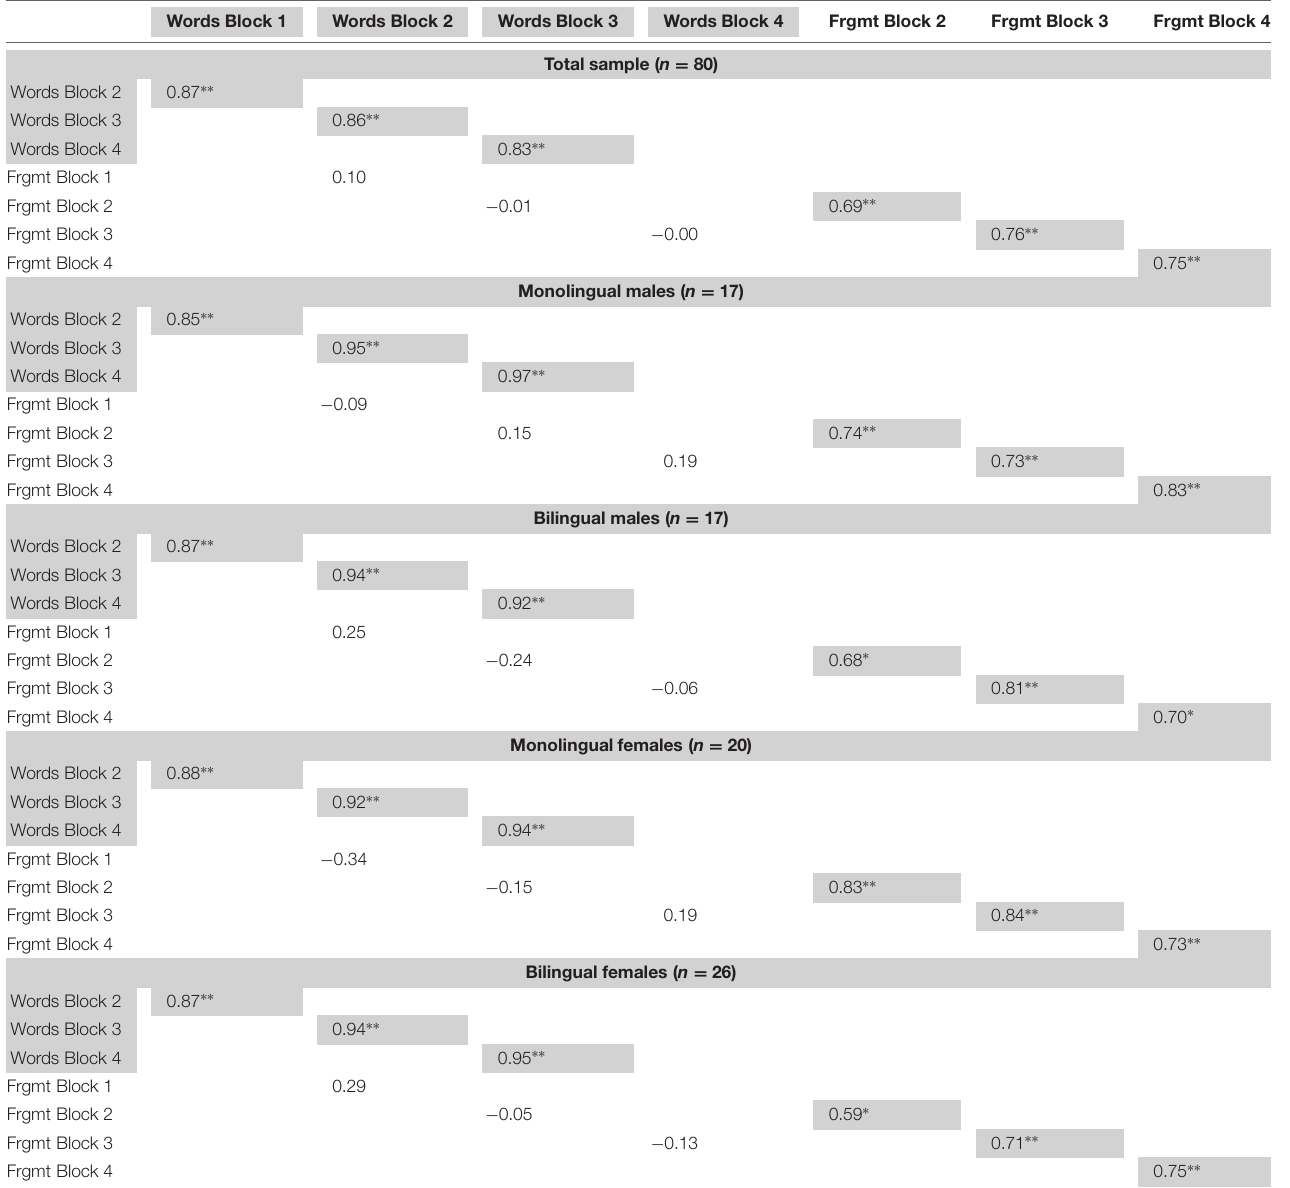
TABLE 4 | Correlations between whole words and word fragments recall scores across memory